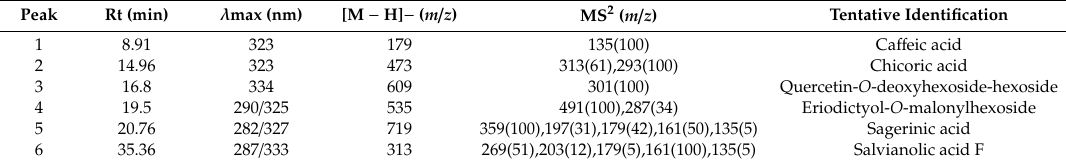
Table 3. Retention time (Rt), wavelengths of maximum absorption in the visible region ( λ max), mass spectral data and tentative identification of the phenolic compounds present in the hydroethanolic extracts of the tested basil